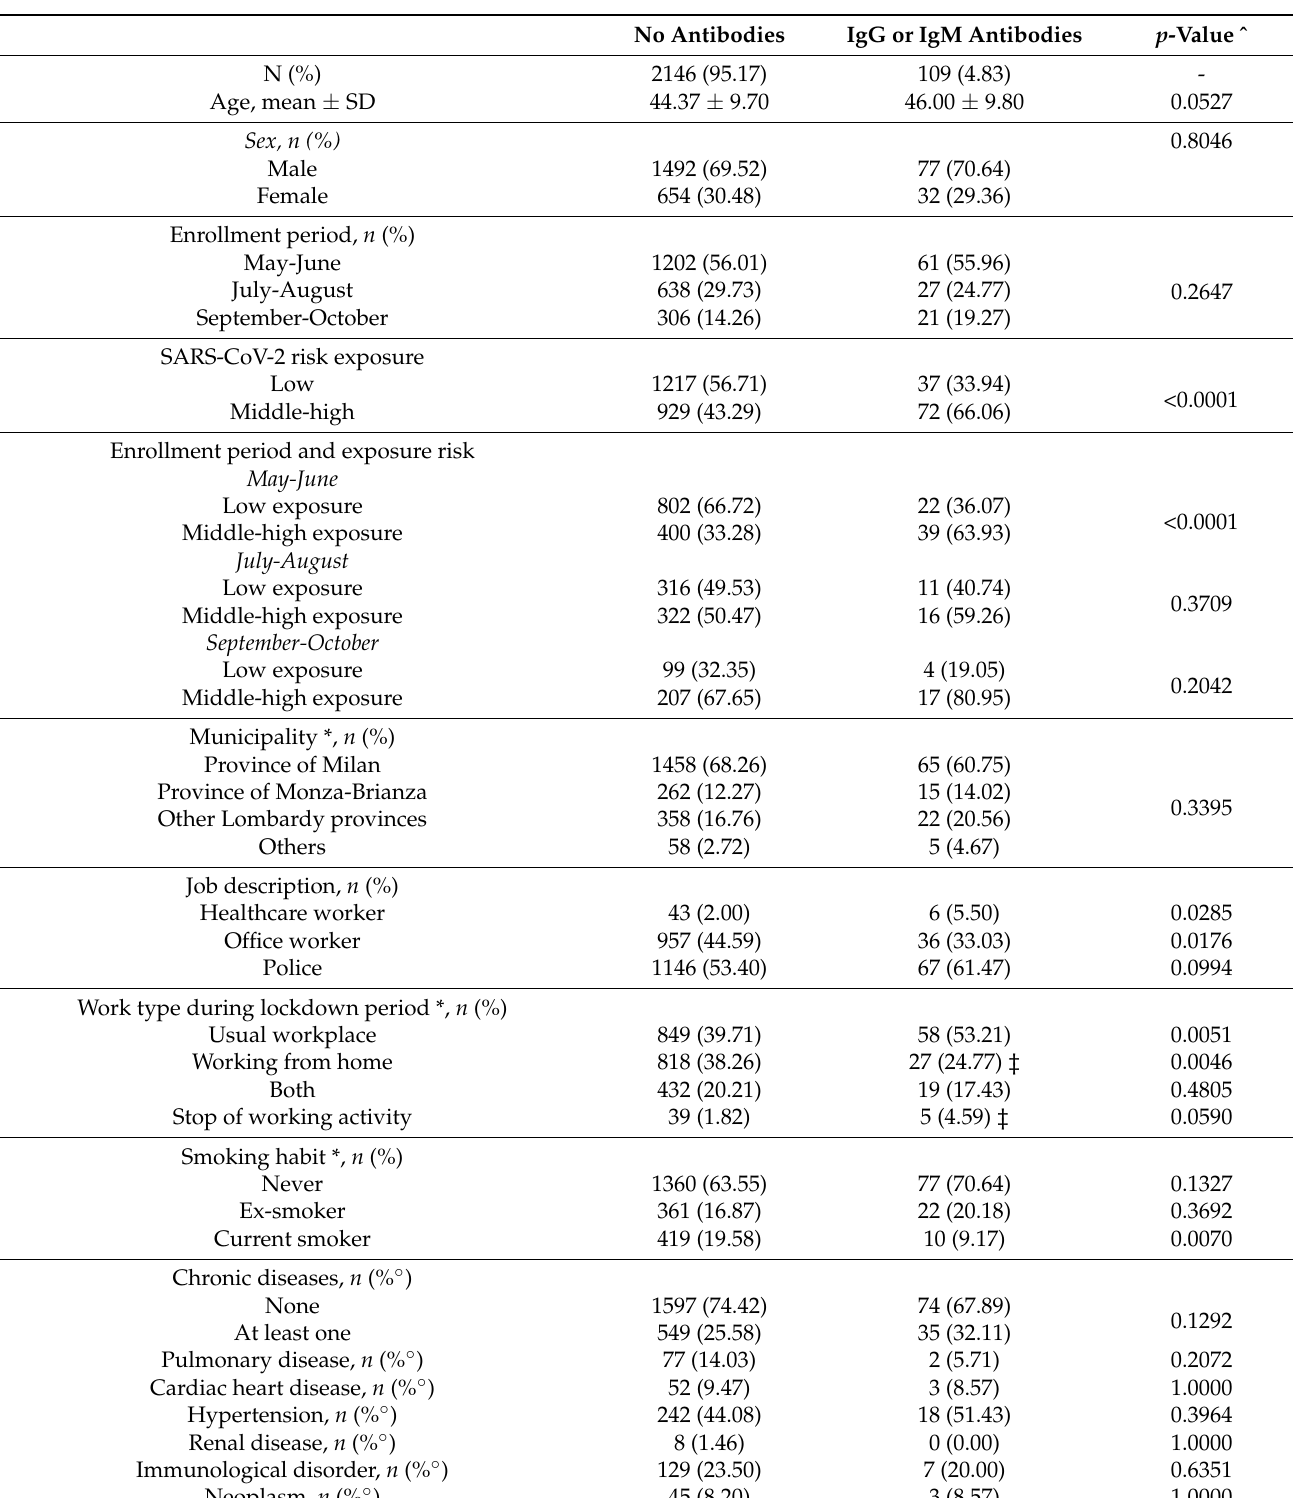
Table 2. Characteristics of study population stratified by presence of antibodies for SARS-CoV-2